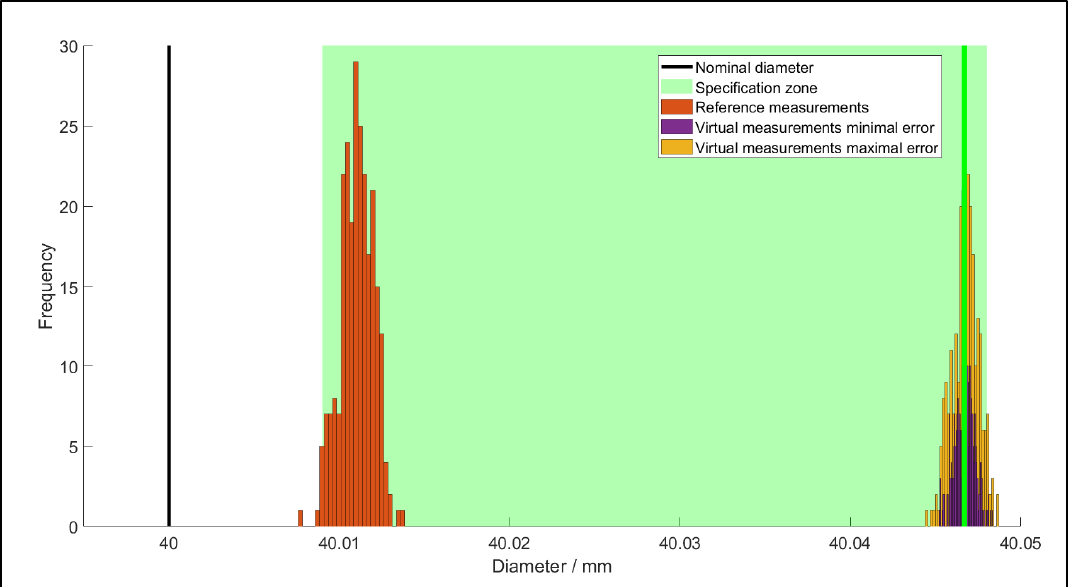
Figure 12. The measurement uncertainty on the measured diameter and the influence on the conformance according to a specified tolerance.